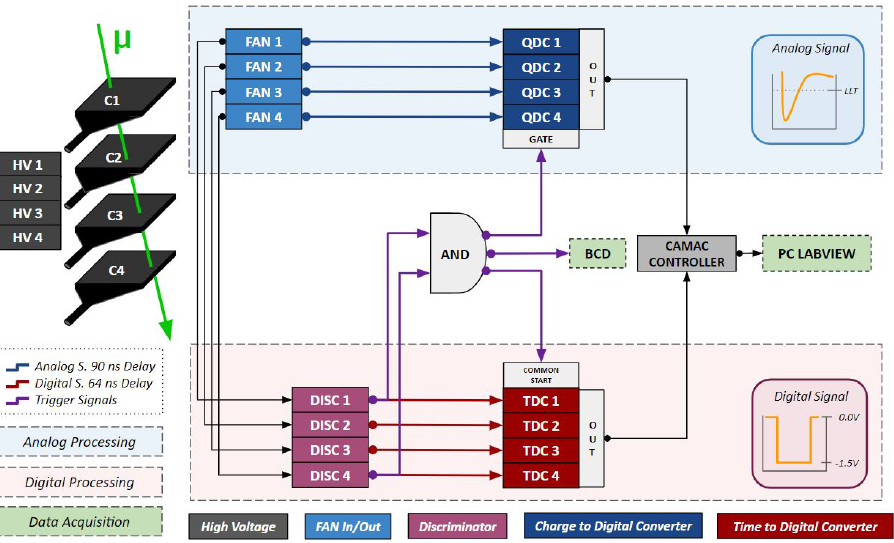
Figure 3. Electronic diagram for the UNIANDES muon telescope. The diagram shows the processing of analog and digital signals and summarizes the signal processing